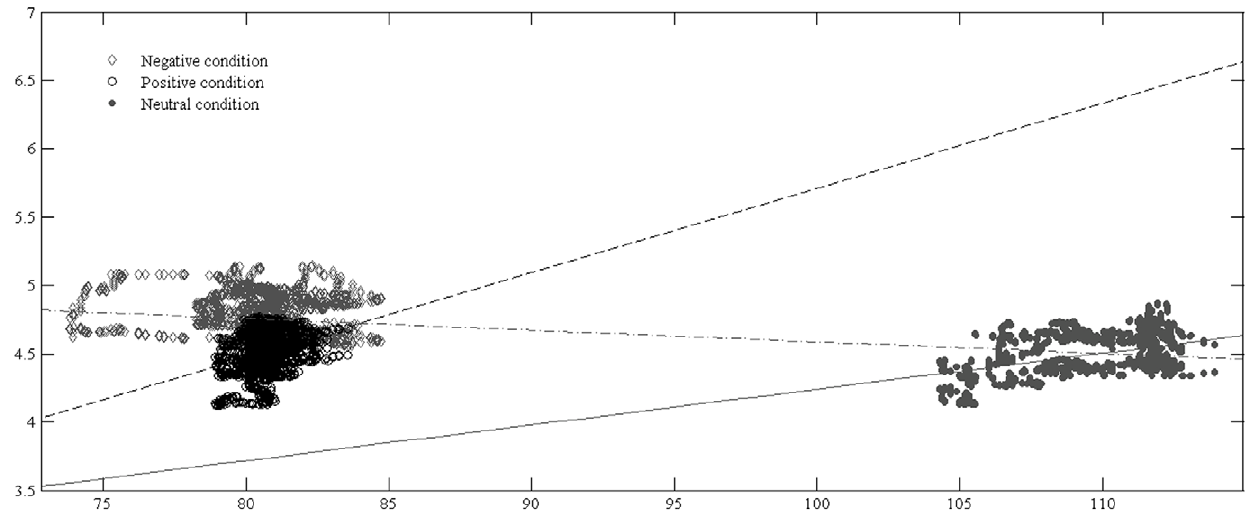
Figure 3. The effect of stimulus luminance on pupil dilation. We explored whether variations in stimulus luminance across video frames have a significant effect on the recorded changes in pupil size. It was predicted that as stimulus luminance increases, an adjustment reaction with decreasing pupil size would be recorded. It was found that the emotional valence of the stimuli explained a big proportion of the variation, partial g 2 =.32, while variations in luminance across the movies had an extremely small effect, partial g 2 =.04. The relation between the effect of luminance on pupil size differed across emotions ( F (2, 7500)=217.77, p , .001). When controlling for other sources of variations between videos [69], the relation between luminance and pupil size is positive (.42), and this could be due to the overall tendency of the pupil to increase with stimulus presentation. Illuminance measured at the level of the eye during the presentation of each video was within a range not expected to yield significant differences in pupil size (15.0 6 0.5 Lux) [50]. All this information suggests that the observed differences in luminance and illuminance between stimuli could not produce the differences in pupil size related to the emotional valence.